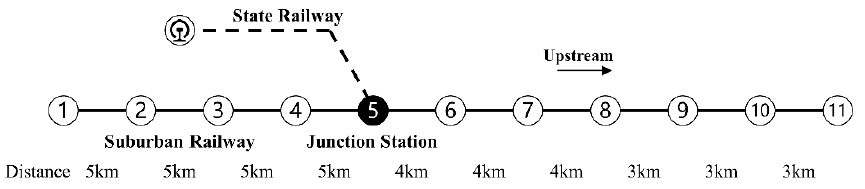
Figure 7. The structure of the operation network.